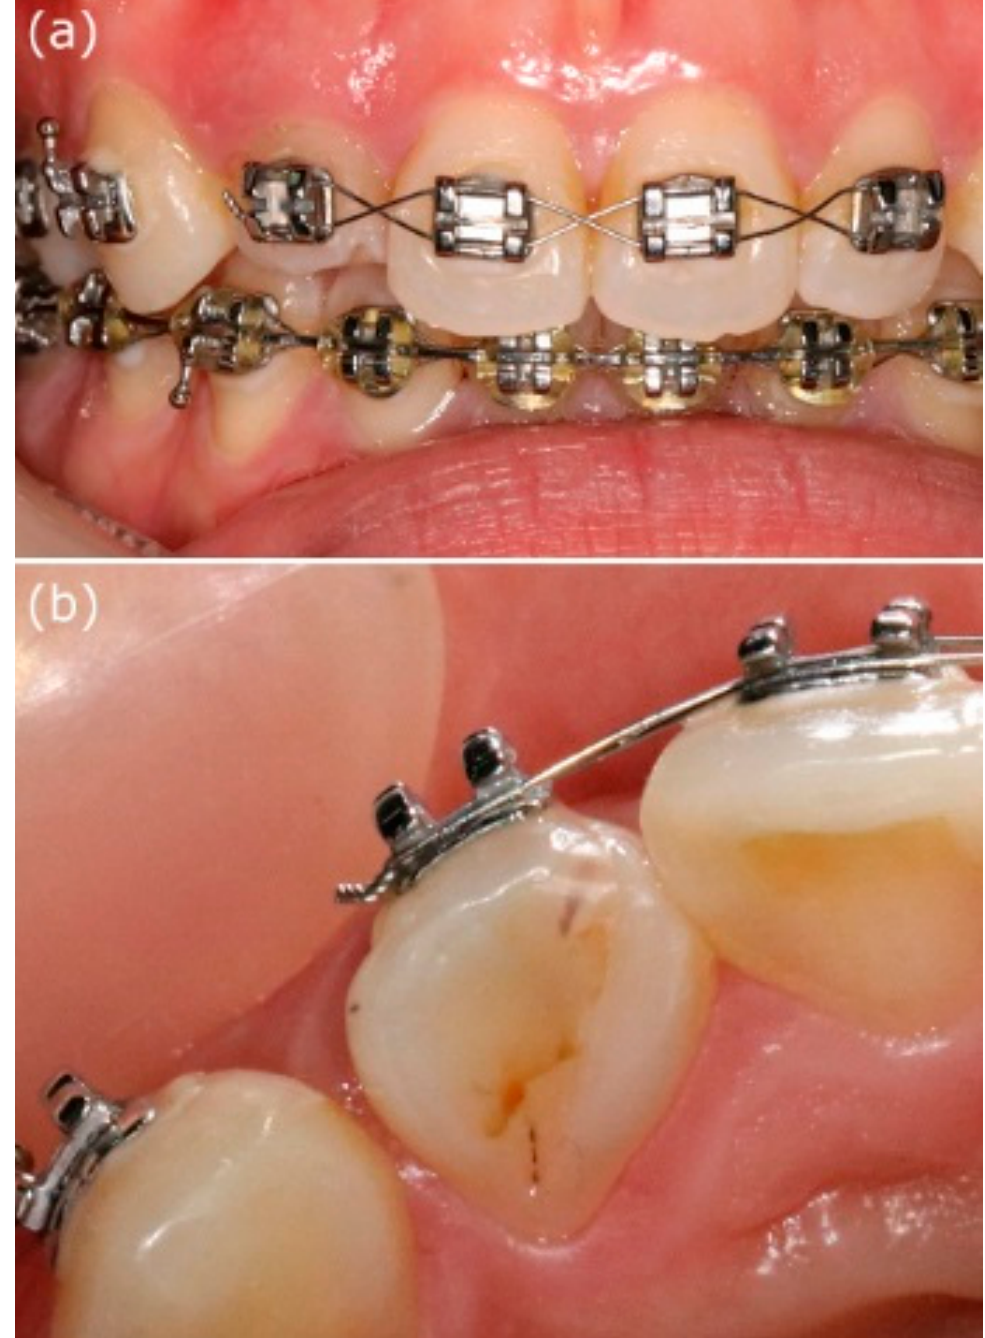
Figure 1. Clinical examination. ( a ) Intraoral examination of a 31-year-old woman showing normal soft tissue. ( b ) Incisal view of tooth 12 showing a Peg-shaped clinical crown.